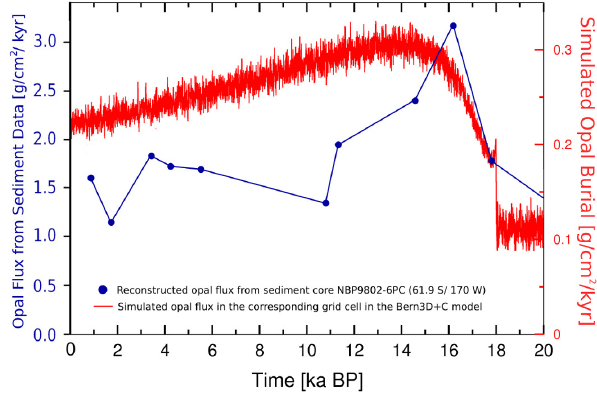
Fig. 10. Reconstructed local opal flux (blue line) at 61.9 ◦ S/170 ◦ W from Anderson et al. (2009) and simulated opal burial rate in the corresponding model cell (red line) as simulated in the experiment with an abrupt 80%-increase in SO wind stress at